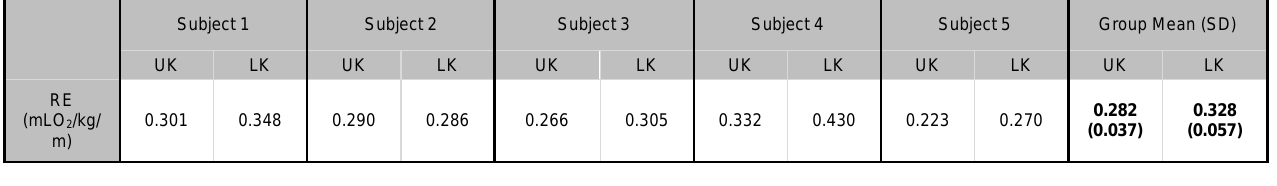
Table 4: Running economy during the three-minute SSRS trials; normalization is exclusive of prosthesis